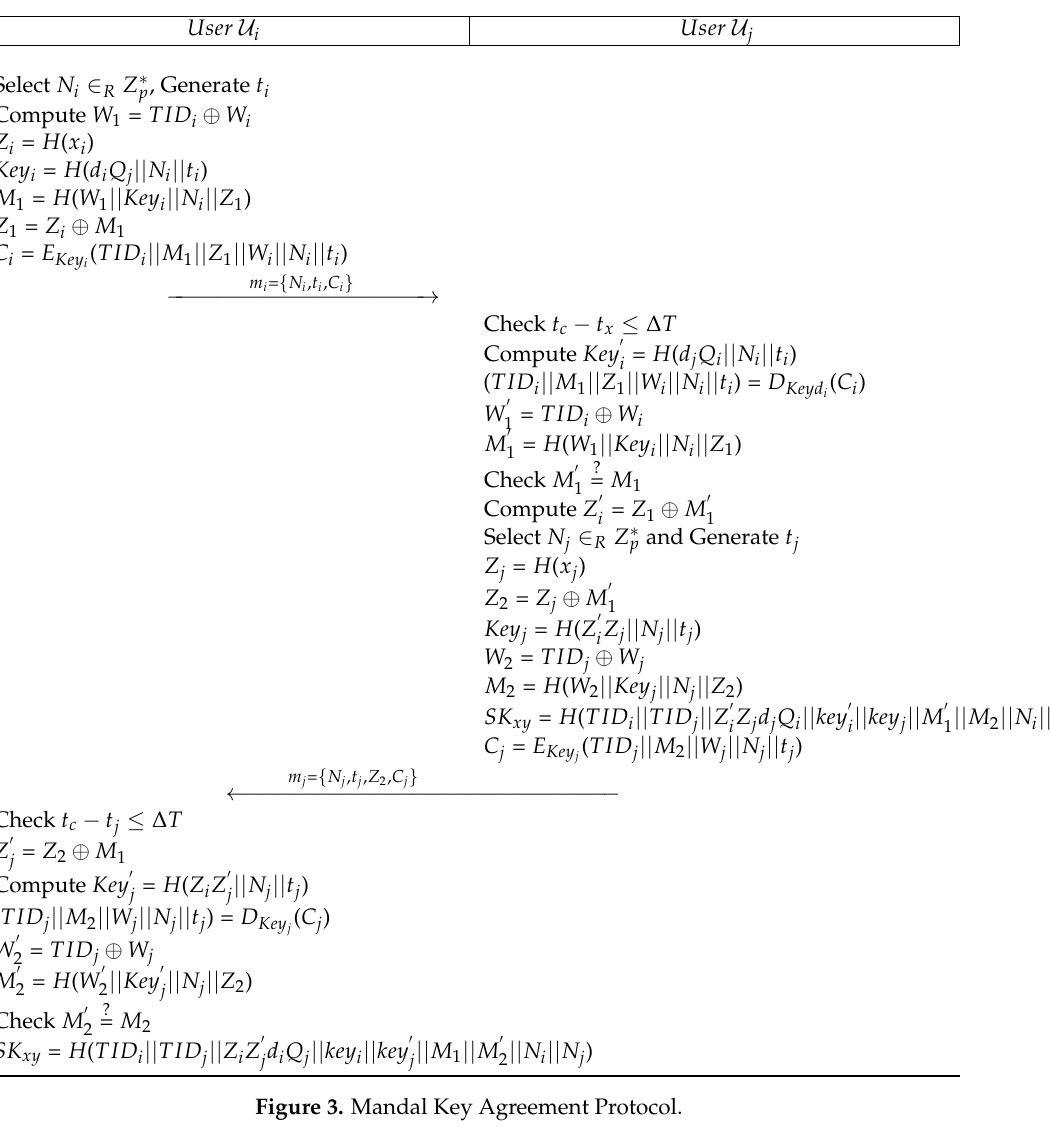
Figure 3. Mandal Key Agreement